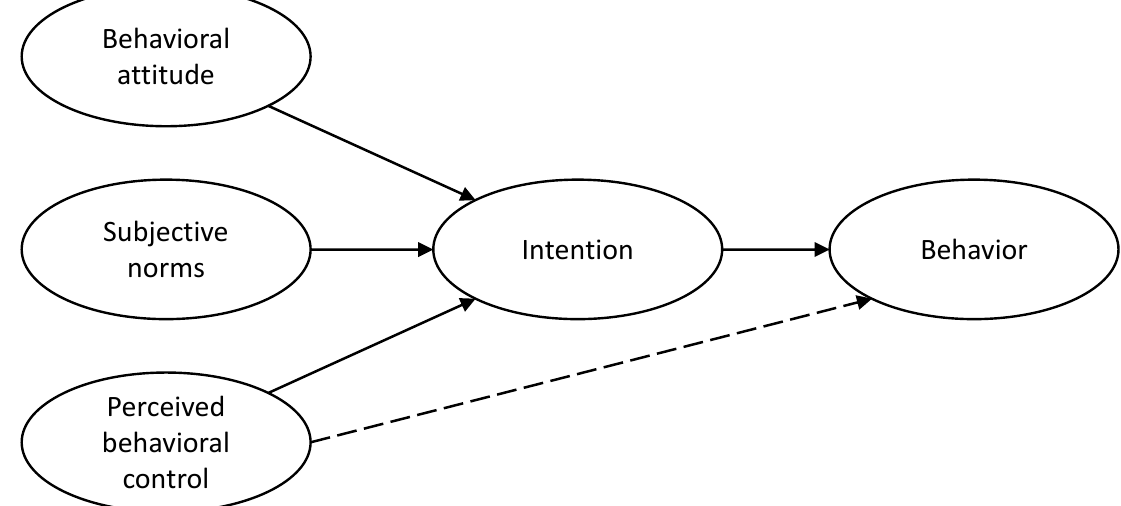
Figure 1. Theory of Planned